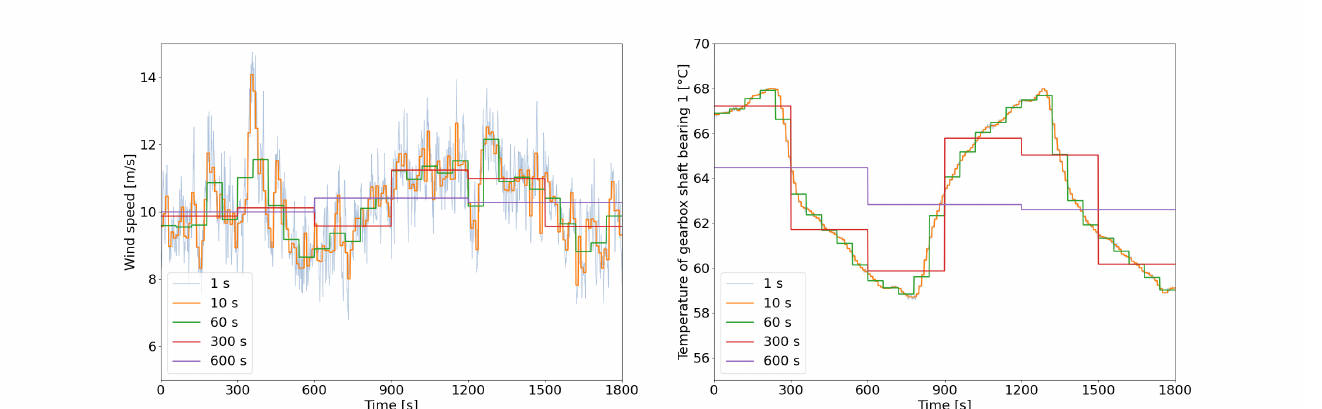
Figure 1. Illustration of temporal aggregation of SCADA operating data at various resolutions: On the left, a highly dynamic signal, the wind speed, loses much of its information even at low resolutions, while the original data of a slowly changing signal on the right, a temperature of the gearbox shaft bearing, is hidden behind the curve of the aggregation resolution of